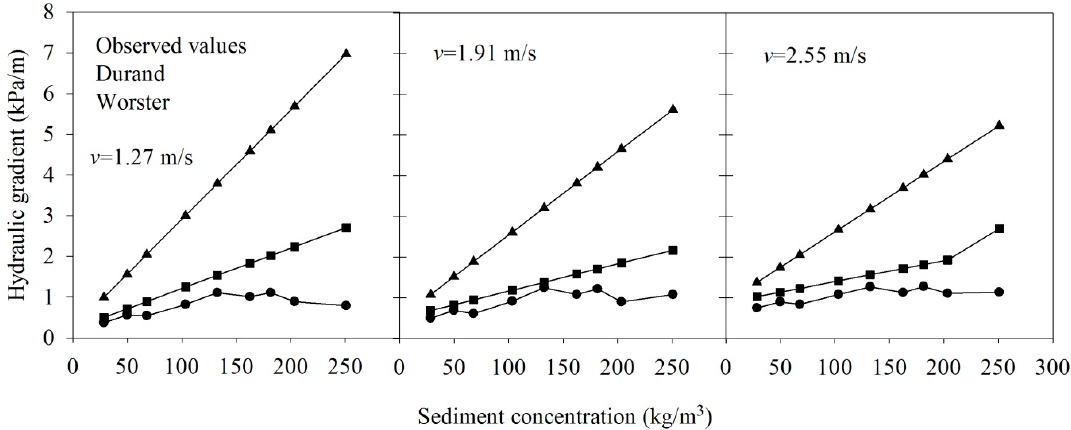
Figure 8. Comparison of the observed and simulated values at different flow velocities (inverse slope = 45°).